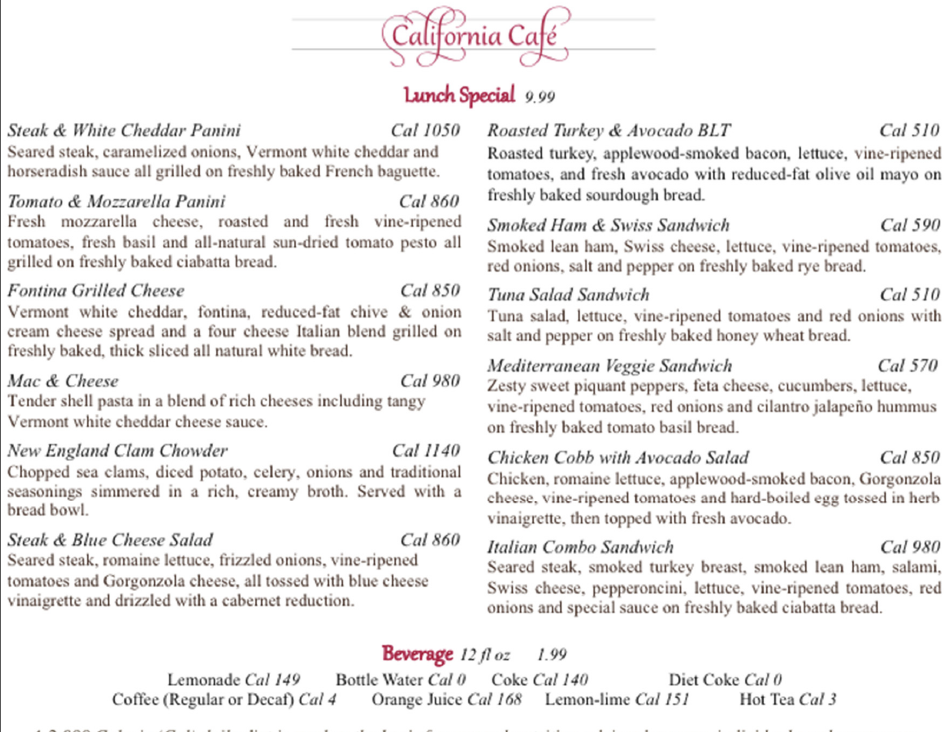
Figure A7. California Cafe Sweet Spot Menu.